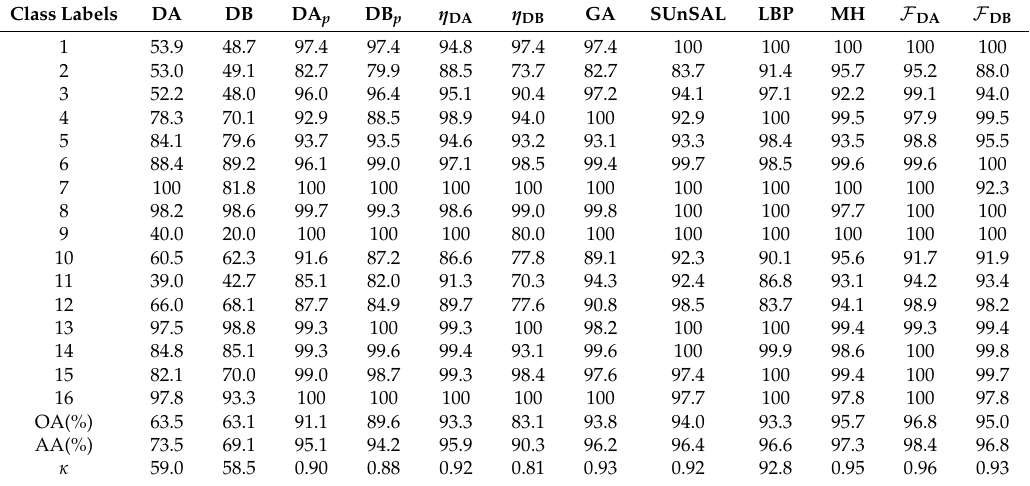
Table 4. Indian Pines dataset: OA, AA and κ value of the classification results. The best classification accuracies are marked in